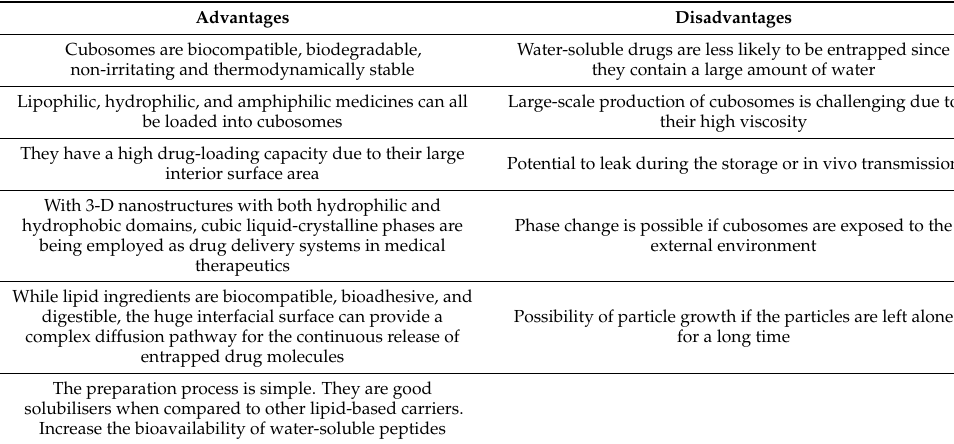
Table 2. Advantages and disadvantages of cubosomes